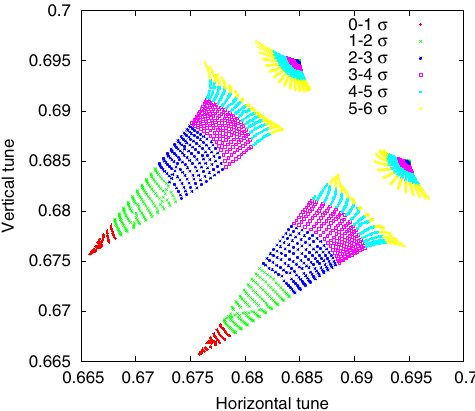
FIG. 2. Tune footprints without and with beam-beam inter- actions with a bunch intensity 2 . 0 × 10 11 . Different colors represent particles with different transverse amplitudes.